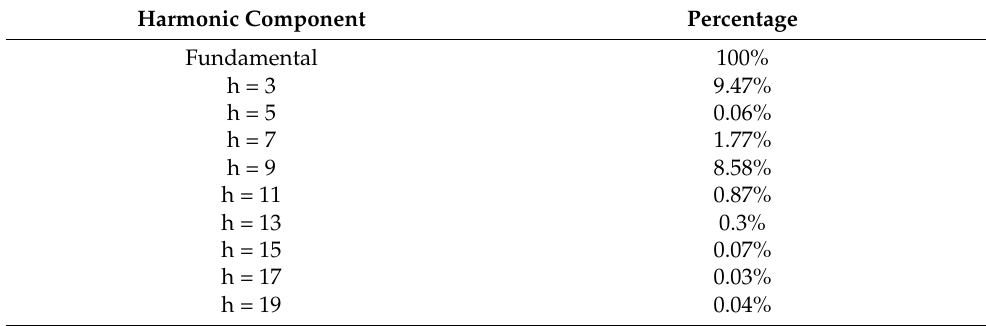
Table 2. Odd harmonic grid current distortion in percent of the fundamental component without APF.